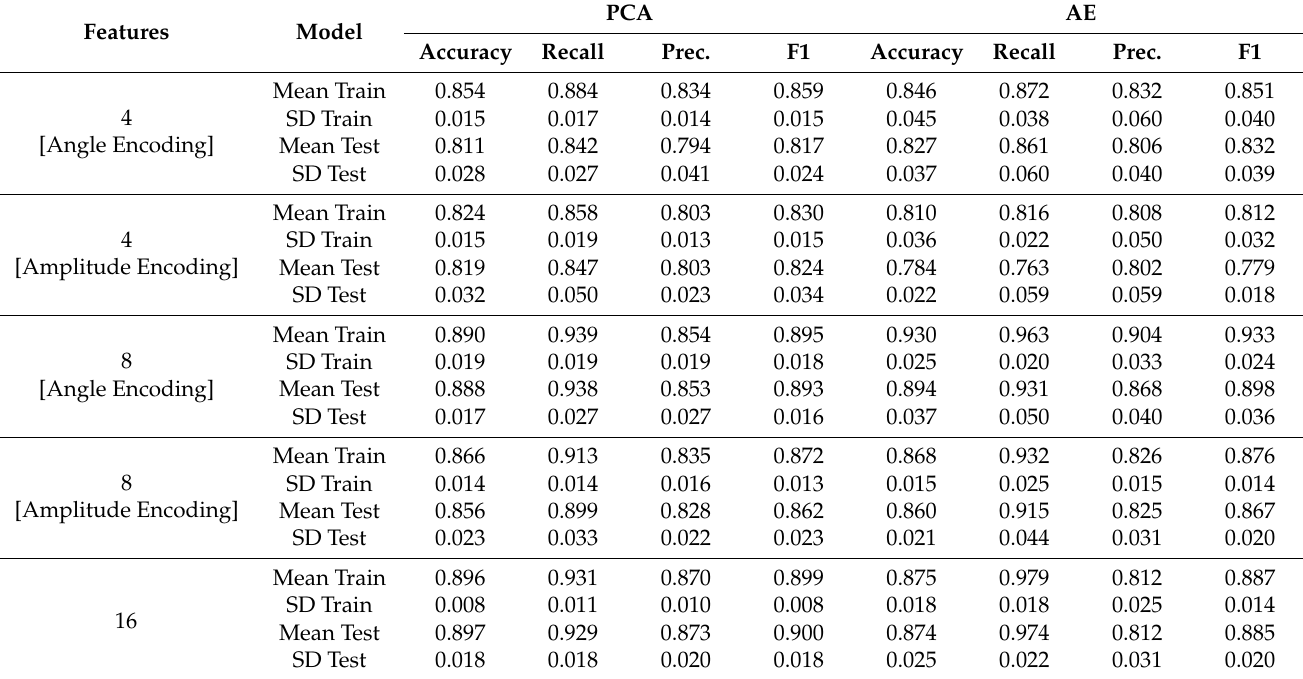
Table A5. Binary classification metrics for SVM-quantum kernel per number of PCs and AE latent space